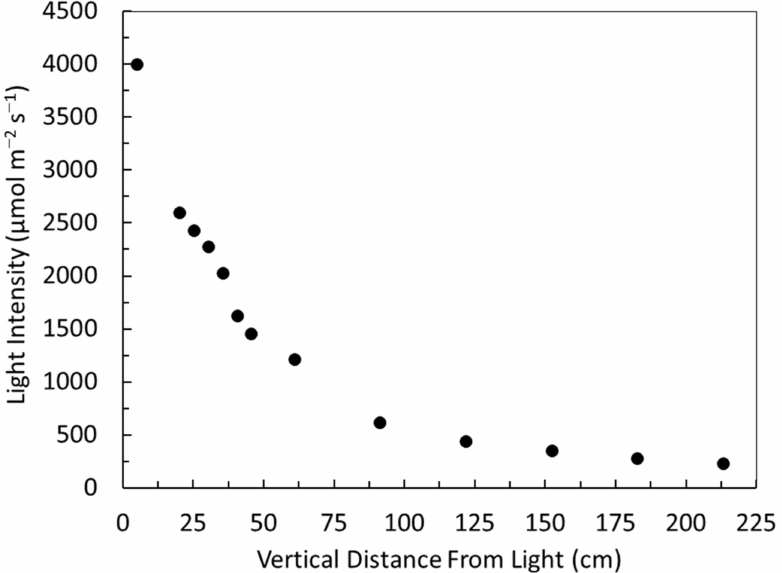
Figure 4. Measured light intensity in the grow room with no plants, as a function of vertical distance from the light